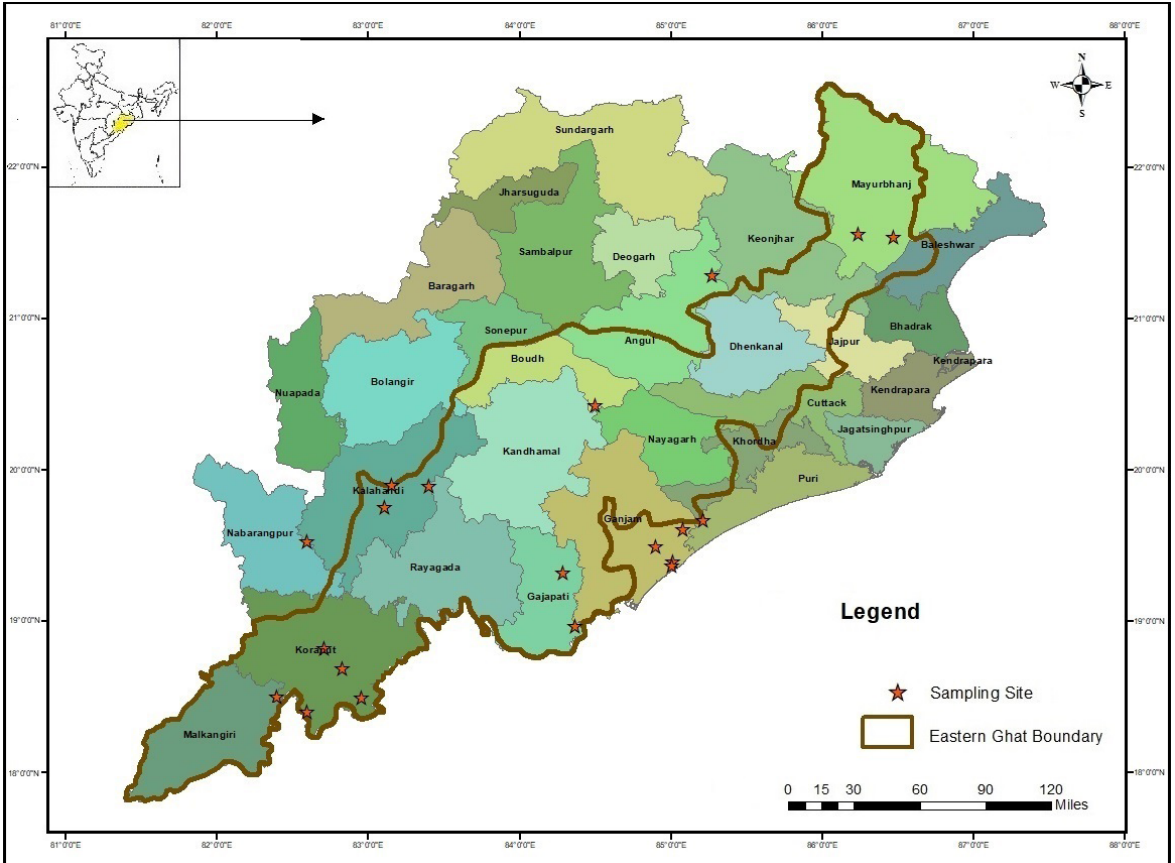
Figure 1. Study area (Source: